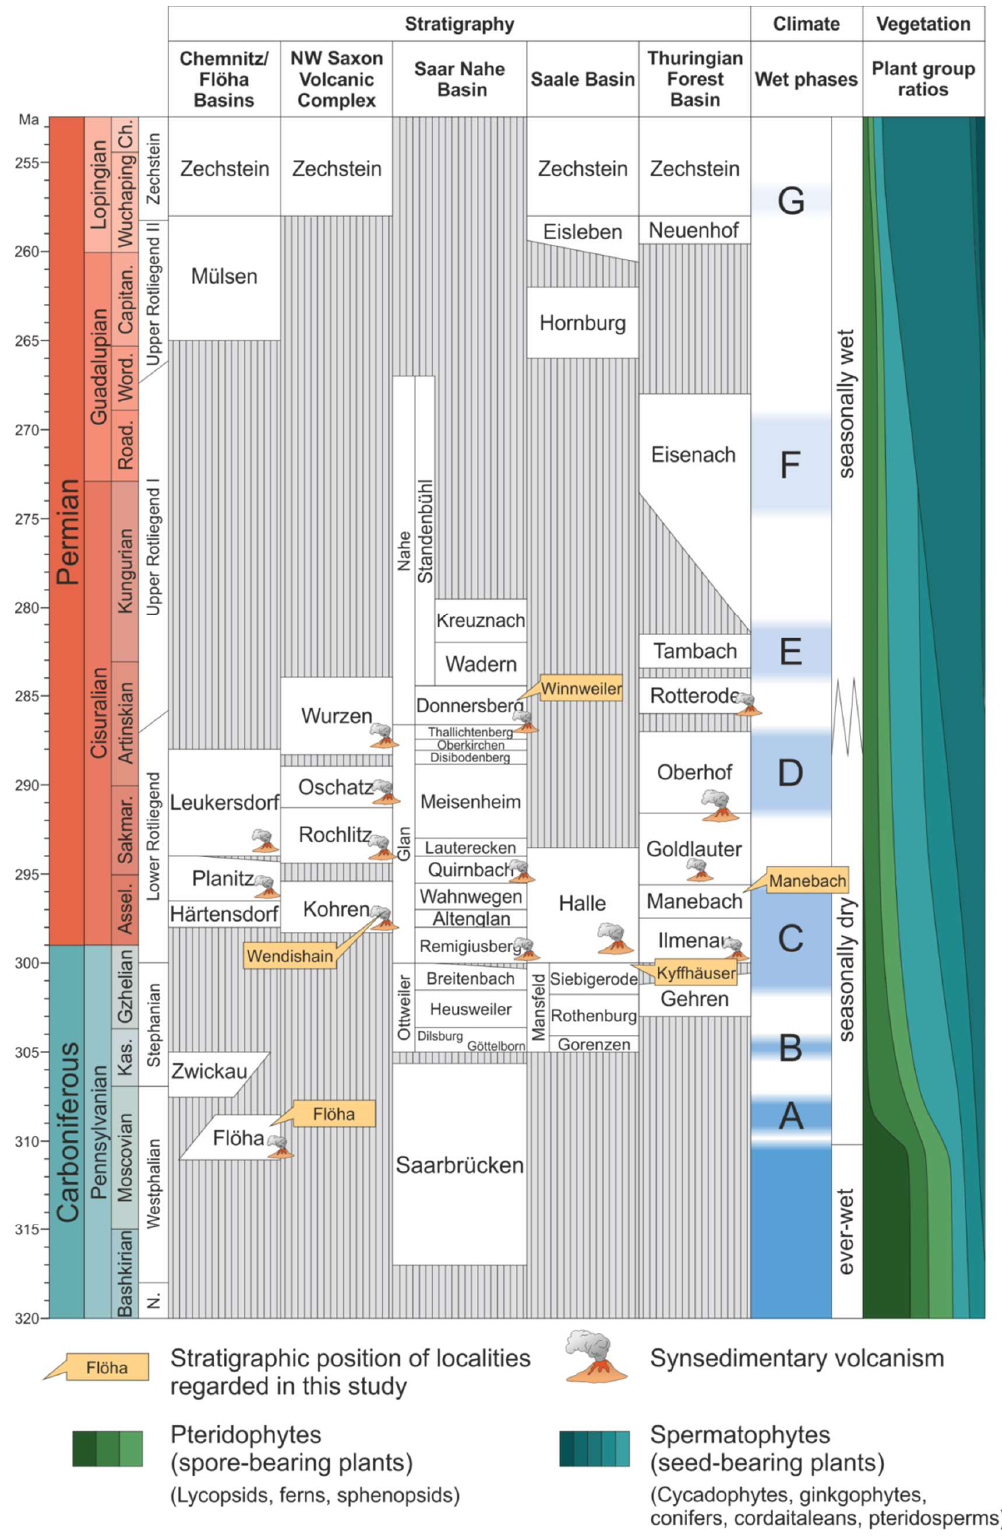
Figure 2. Lithostratigraphy of selected late Paleozoic intramontane basins. Tectonic basin formation around the Carboniferous-Permian boundary is accompanied by volcano-sedimentary deposits and abundant hiati in the stratigraphic record. From the middle Pennsylvanian onwards, gradual aridization favored the expansion and diversification of seed-bearing plants including wood-forming gymnosperms (conifers, cordaitaleans, ginkgophytes). Compiled and modified after [36,44–46]. Vegetation data are based on [38,39,47] and personal observations.